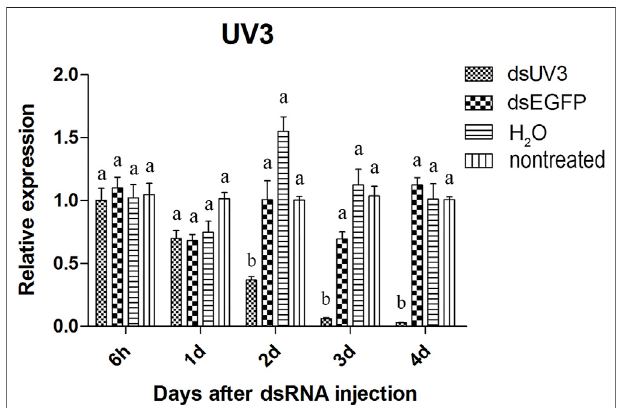
FIGURE6| Relativeexpressionof UVopsin3 inEABadultsafterdsRNA injection. Relative expression of UV opsin 3 byRT-qPCR assaywasevaluated 6 hours, 1, 2, 3 and 4 days after injecting 3 µg dsRNA. TEF-1 α was used as a reference gene for normalization. Means ± SE (n = 4) are shown. StatisticalanalyseswereperformedusingANOVA/LSDmethodat p < 0.05for comparison among treatments. Statistical differences are shown by different letters between different treatments at the same time